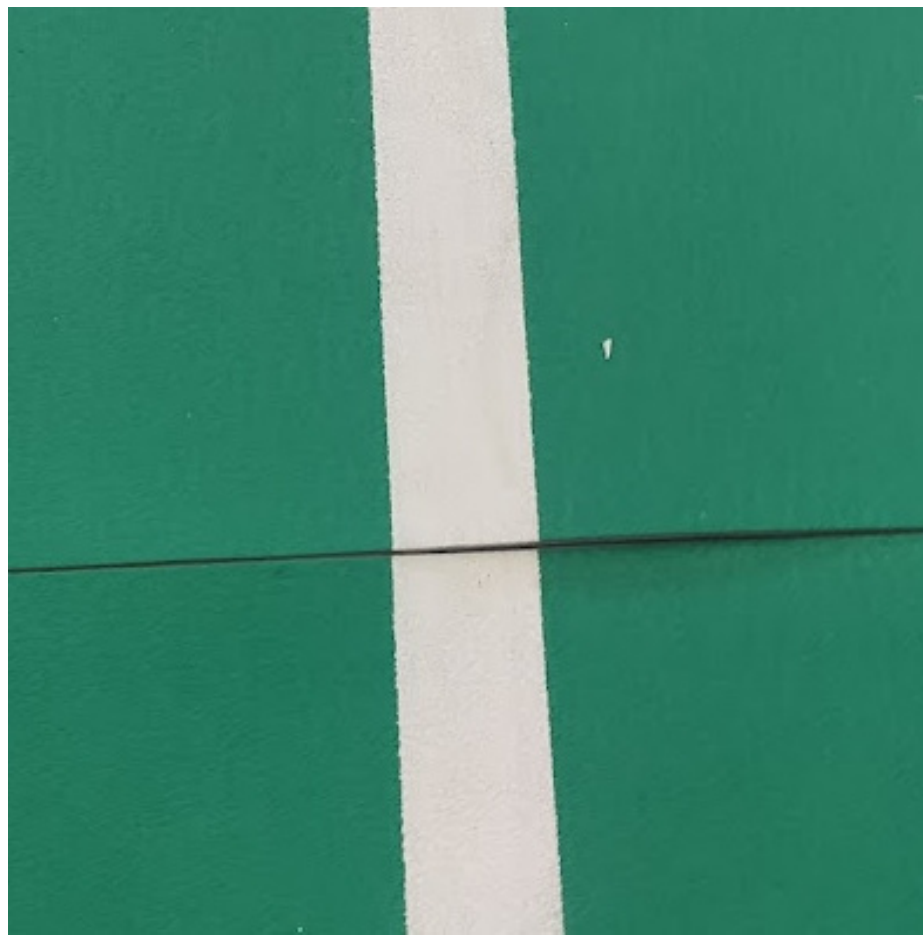
Figure 2. Deformation of a playing mat during the game.